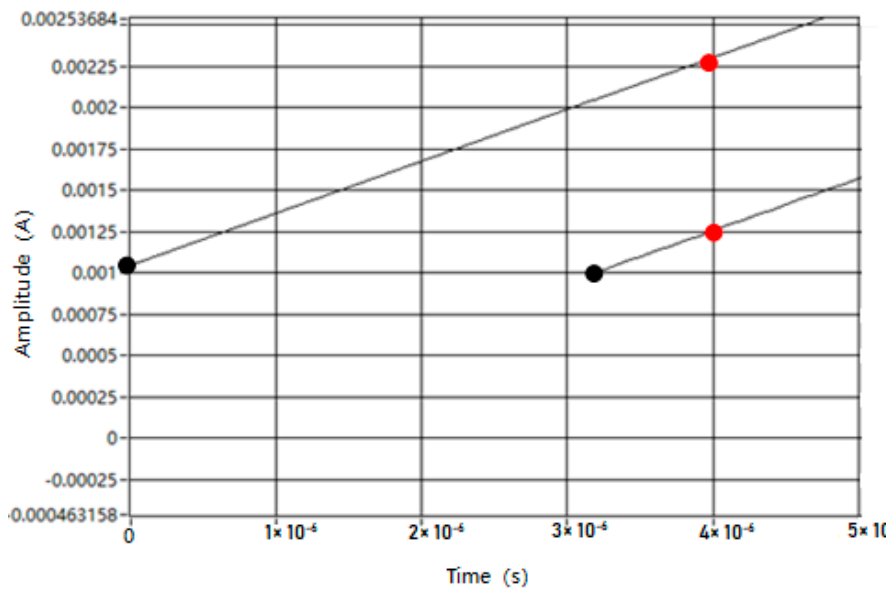
Figure 8. Two-channel waveform used for data acquisition.